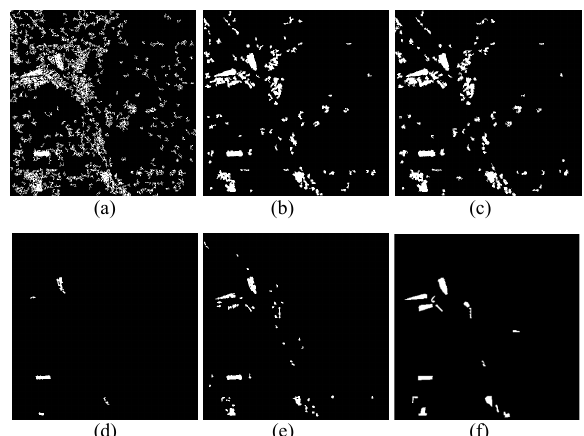
Figure 7. Results of Luchengxiang dataset: (a) LR-FCM. (b) NR-ELM. (c) GarborPCANet. (d) NAWL. (e) Proposed. (f) Reference